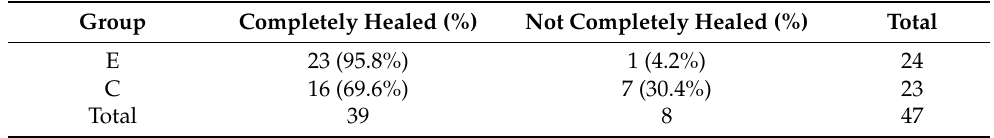
Table 2. The completely healed percentage of two groups. Group Completely Healed (%) Not Completely Healed (%) Total E 23 (95.8%) 1 (4.2%) 24 C 16 (69.6%) 7 (30.4%) 23 Total 39 8 47 The chi-square with Yate’s correction analysis was applied ( χ 2 = 4.03, E vs. C, odds ratio (95% CI) = 10.06 (1.13, 89.94), p = 0.045*). E, experimental group; C, control group.